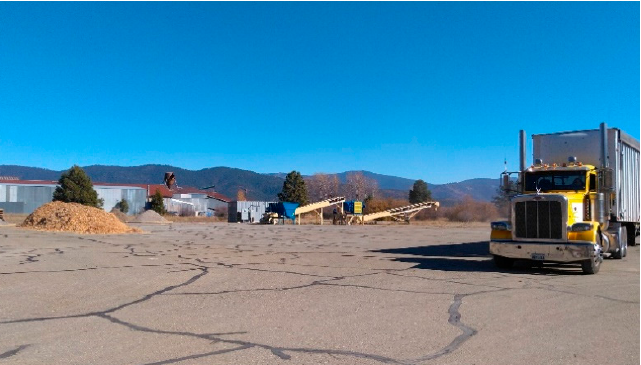
Figure 1. Biomass storage at the Crescent Mills Campus in Plumas County (photo credit: Sierra Institute for Community and Environment).